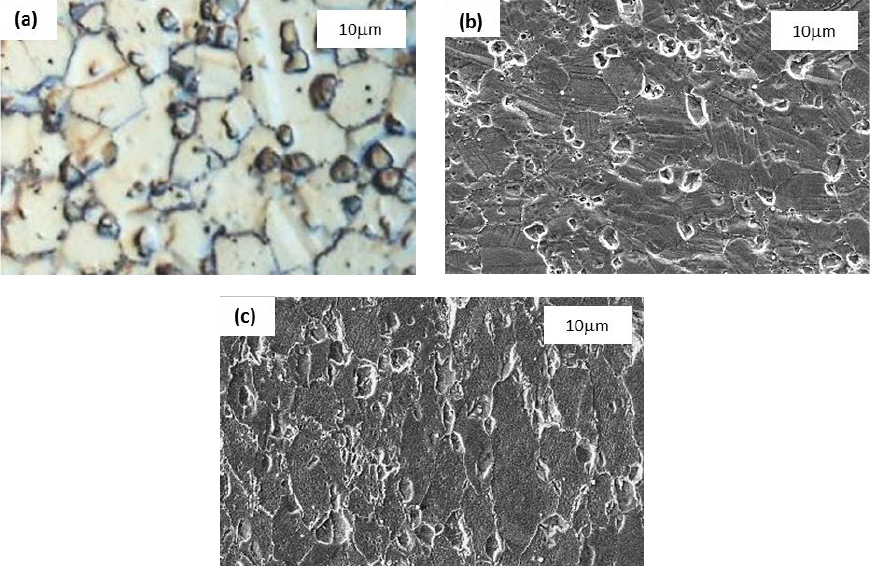
Figure 5. Typical microstructures from ( a ) pre swaged RR1000 ( X - Y plane, optical microscopy); ( b ) post swaging ( X - Y plane, secondary electron SEM) and ( c ) post swaging (along Z axis, SEM).